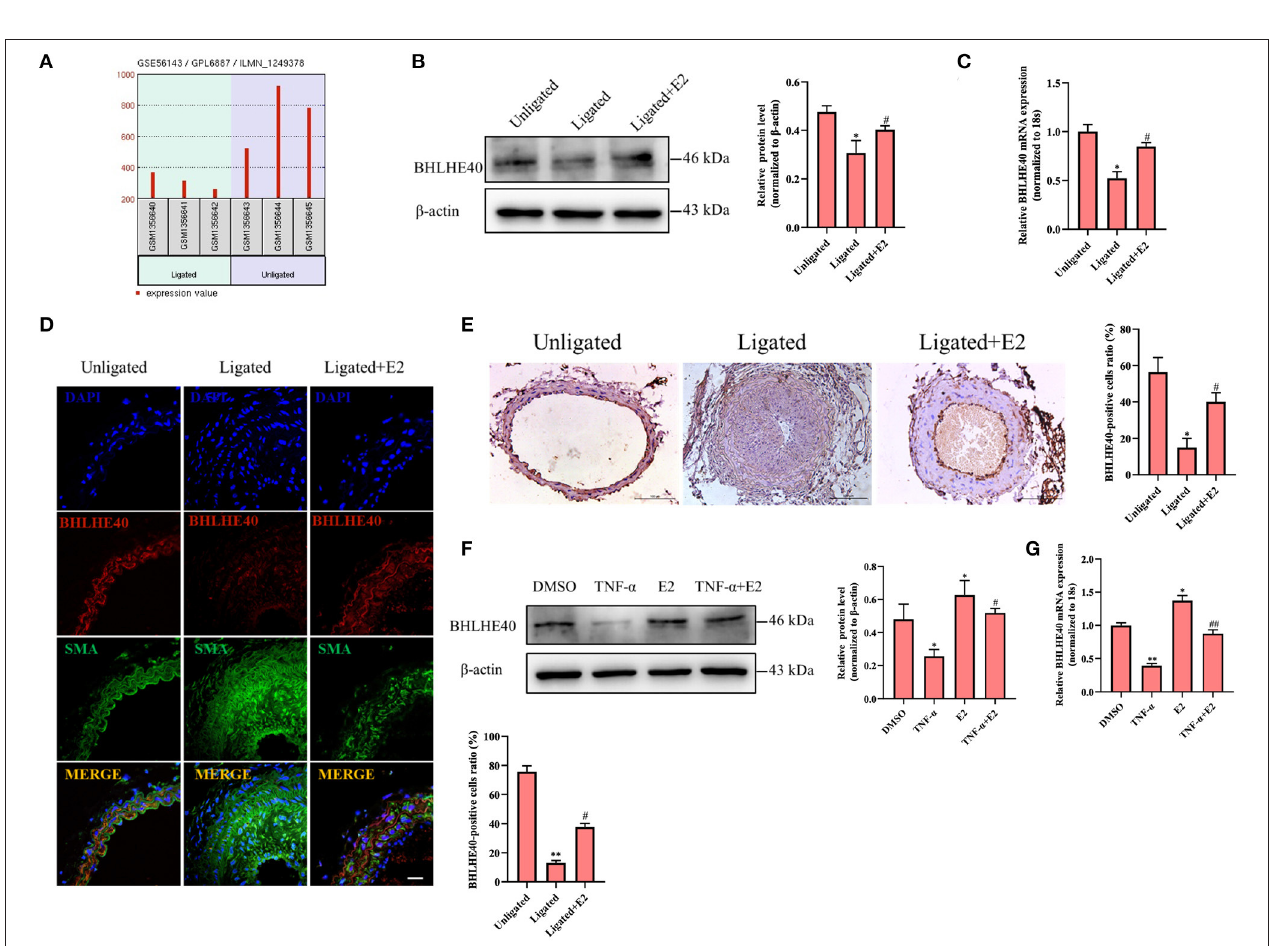
FIGURE 3 | E2 promotes the expression of BHLHE40 both in vivo and in vitro . (A) The data of BHLHE40 expression was downloaded from the GEO databases (GSE56143). (B,C) BHLHE40 expression in unligated, ligated and ligated + E2-treated carotid arteries was detected by Western blotting (B) and qRT-PCR (C) . Statistic of band intensities is shown on the right. * p < 0.05 vs. Unligated group, # p < 0.05 vs. Ligated group. (D) Immunofluorescence staining of a-SMA (SMA; green), BHLHE40 (red) and the nucleus (DAPI; blue) in unligated, ligated and ligated + E2-treated carotid arteries. Scale bars = 25 µ m. Statistics of BHLHE40-positive cells unligated, ligated and ligated + E2-treated carotid arteries is shown on the right. ** p < 0.01 vs. Unligated group, # p < 0.05 vs. Ligated group. (E) Immunochemistry staining of BHLHE40 in unligated, ligated and ligated + E2-treated carotid arteries. Scale bars = 100 µ m. Statistics of BHLHE40-positive cells unligated, ligated and ligated + E2-treated carotid arteries is shown on the right. * p < 0.05 vs. Unligated group, # p < 0.05 vs. Ligated group. (F,G) VSMCs were pretreated with 100nM of E2 for 6h and then were stimulated with TNF- α (10ng/mL) for 24h, the expression of BHLHE40 was determined by Western blotting (F) and qRT-PCR (G) . Statistic of band intensities is shown on the right. * p < 0.05 and ** p < 0.01 vs. DMSO group, # p < 0.05 and ## p < 0.01 vs. TNF- α group.